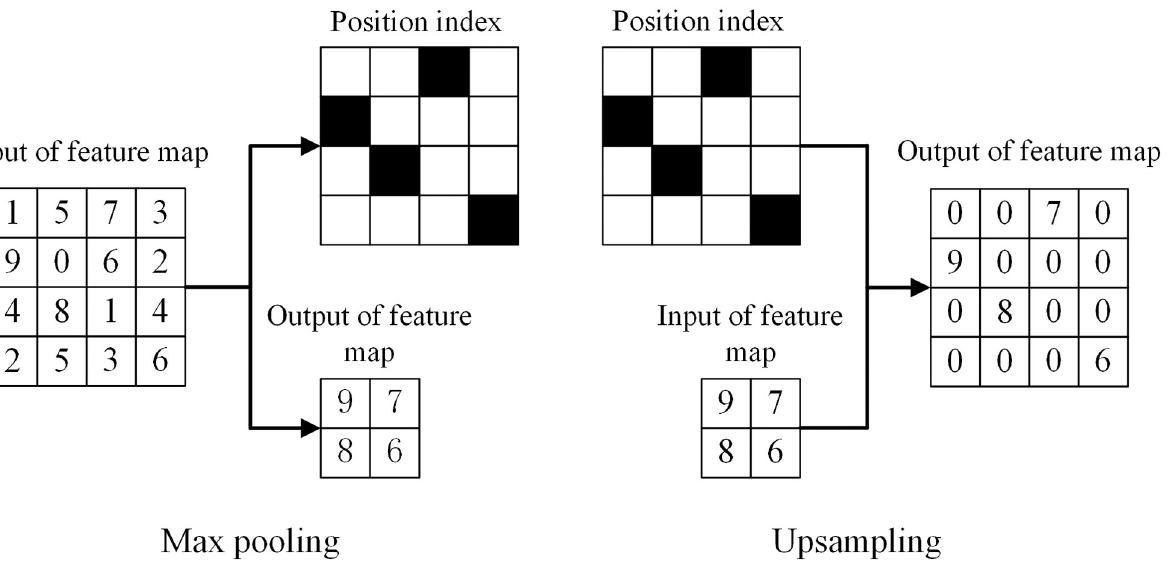
there are few or even not any labeled data in target domains. To the small sample image data sets in this article, transfer learning with the well trained CNN model of VGG16 in image clas- sification can migrate to pixels classify model. Upsampling and deconvolution. Each pixel that corresponds to the rice seedlings, back- grounds, and weeds in the images was classified based on SegNet. As shown in Fig 4 as the flow diagram on the left, data were lost and the input of the feature map is half the size of the output of a maxpooling operation, which leads to the progressive diminishment of the mar- ginal information on the rice seedlings and weeds and to this information being obscured by the process of each section of the encoder. In the process of each section of the decoder, upsampling and deconvolution were utilized to preserve the size of the output image of SegNet